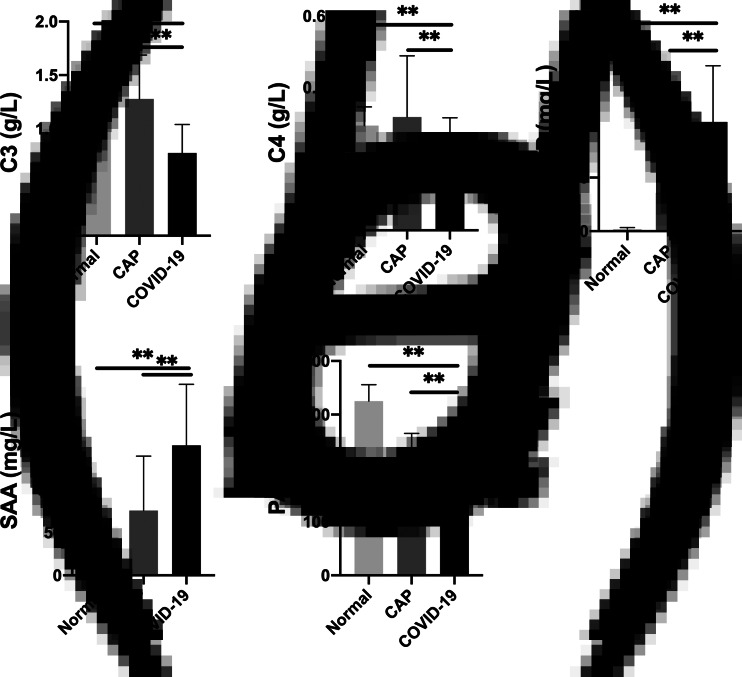
Different APRP contents in COVID-19 patients, CAP patients and the normal control group (**P < 0.01).